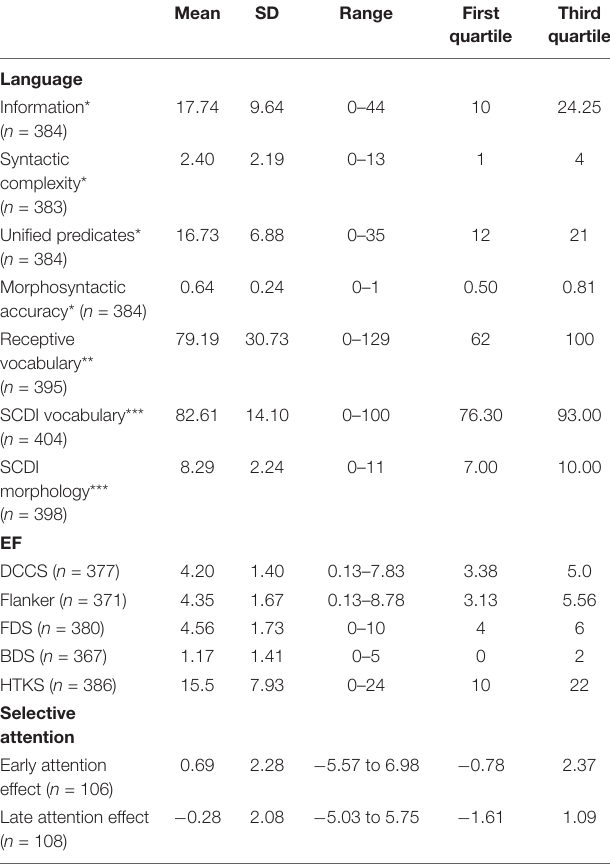
TABLE 1 | Raw scores for the language, EF, and selective attention